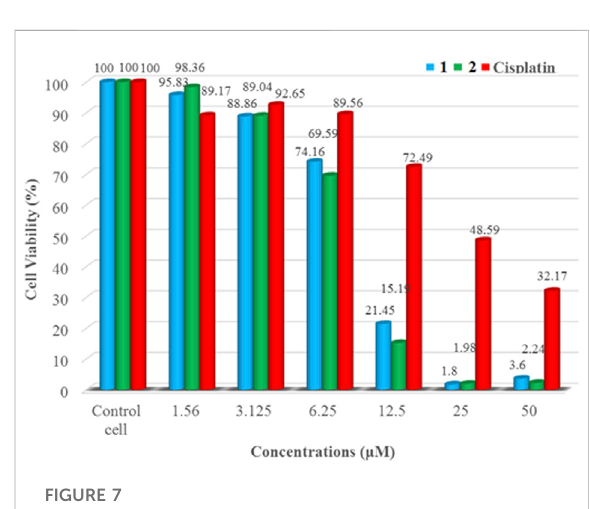
FIGURE 7 Cell viability of MCF-7 cancer cell line against complexes 1 and 2 and cisplatin.